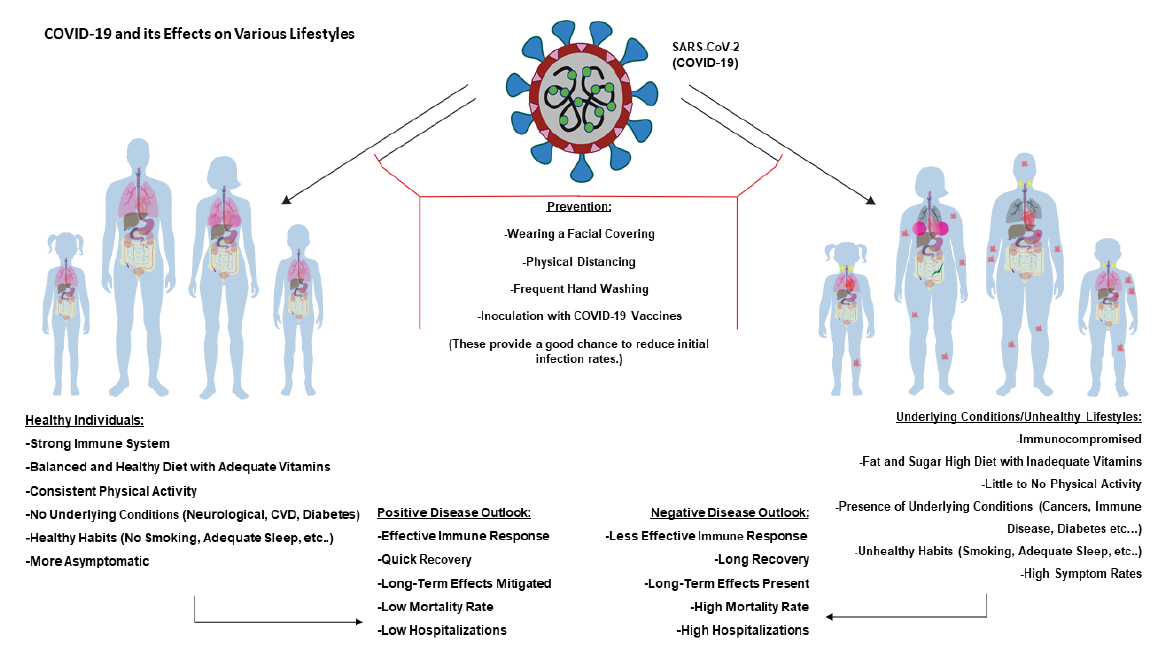
Figure 4: Diagrammatic representation of COVID-19 acting on various lifestyles. Left panel shows healthy male/female and child/adult. Due to their healthy lifestyle choices, adequate intake of nutrients, consistent physical activity, and no underlying conditions, they can present a positive disease outlook. This indicates that the majority of those with healthy lifestyles will muster effective immune responses, quick recoveries, low mortalities, and few hospitalizations. Conversely, right panels show unhealthy in- dividuals presenting opposite conditions as those of healthy individuals. They will majorly experience less effective immune responses, longer recovery times, more long-term effects, higher mortalities, and more hospitalizations. However, both groups can greatly benefit from prevention techniques including wearing facial coverings, physical distancing, adequate handwashing, and receiving a COVID-19 vac-